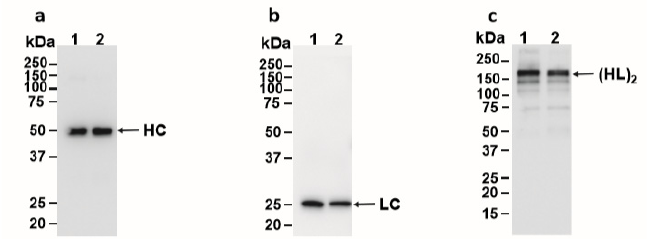
Figure 3. Western blot analysis of ATPS-purified E16. ATPS- or Protein A column-purified E16 was separated on 12% SDS-PAGE gels under reducing ( a and b ) conditions or on a 4–20% SDS-PAGE gel under non-reducing ( c ) conditions and blotted onto polyvinylidene fluoride (PVDF) membranes. A goat anti-human gamma chain antibody ( a and c ) or a goat anti-human kappa chain antibody ( b ) were incubated with the membranes to detect heavy chain or light chain, respectively. Lane 1, ATPS-enriched E16; Lane 2, Protein A column-purified E16. HC: heavy chain, LC: light chain, (HL) 2 : assembled mAb with two light and heavy chains.